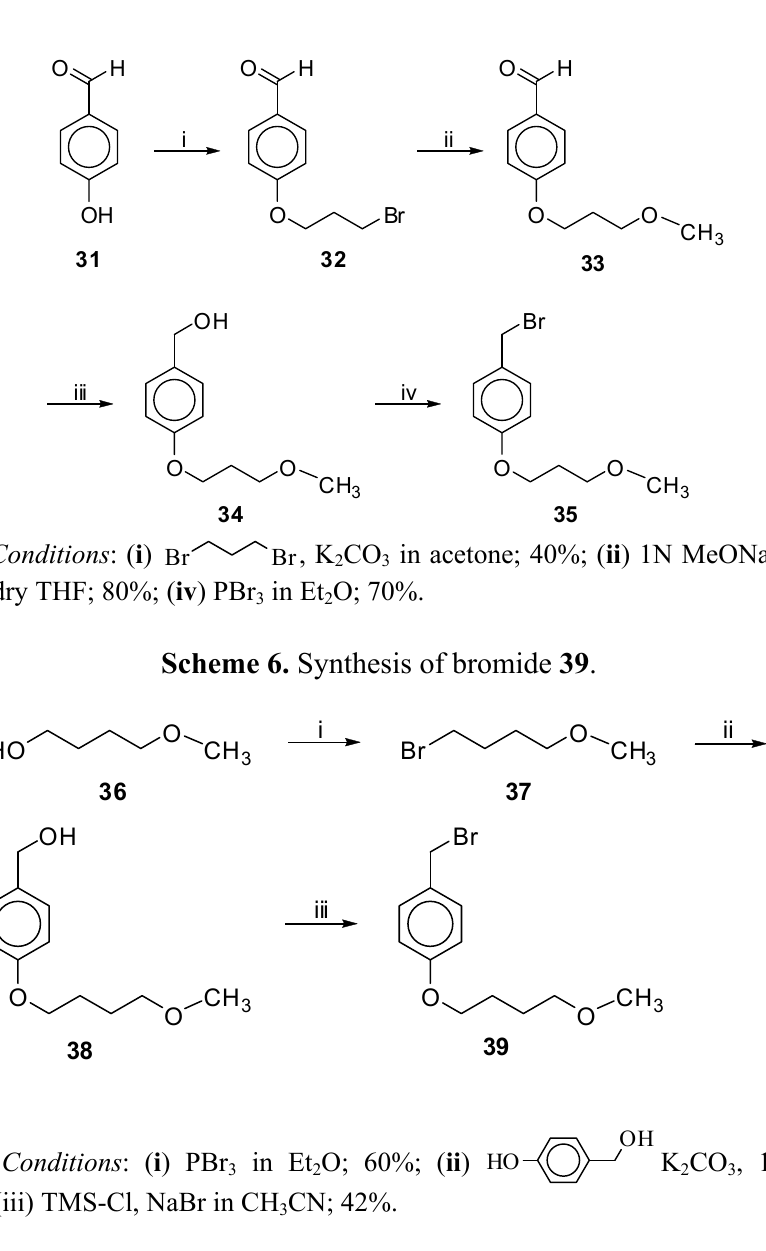
Scheme 5. Synthesis of bromide 35 .